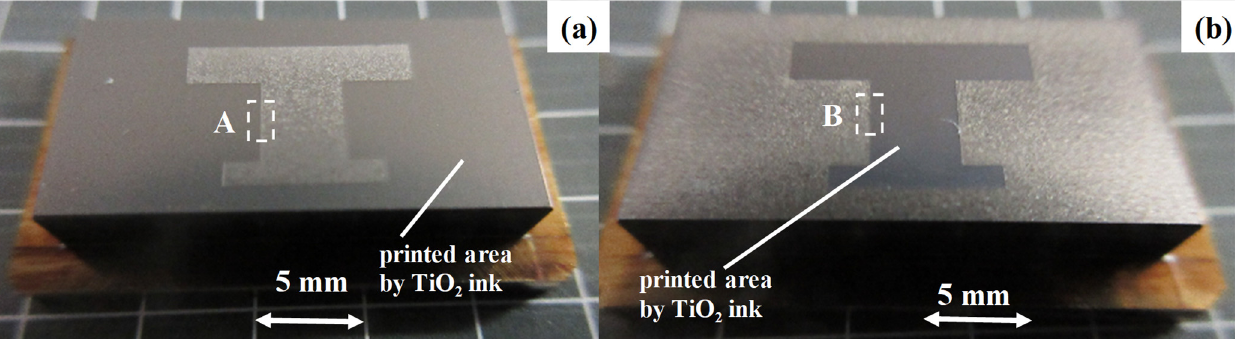
Figure 5. Optical microscopy images on nitrided substrates with negative and positive micropat- terns. ( a ) Substrate with the negative micropattern, and ( b ) substrate with the positive micropattern.